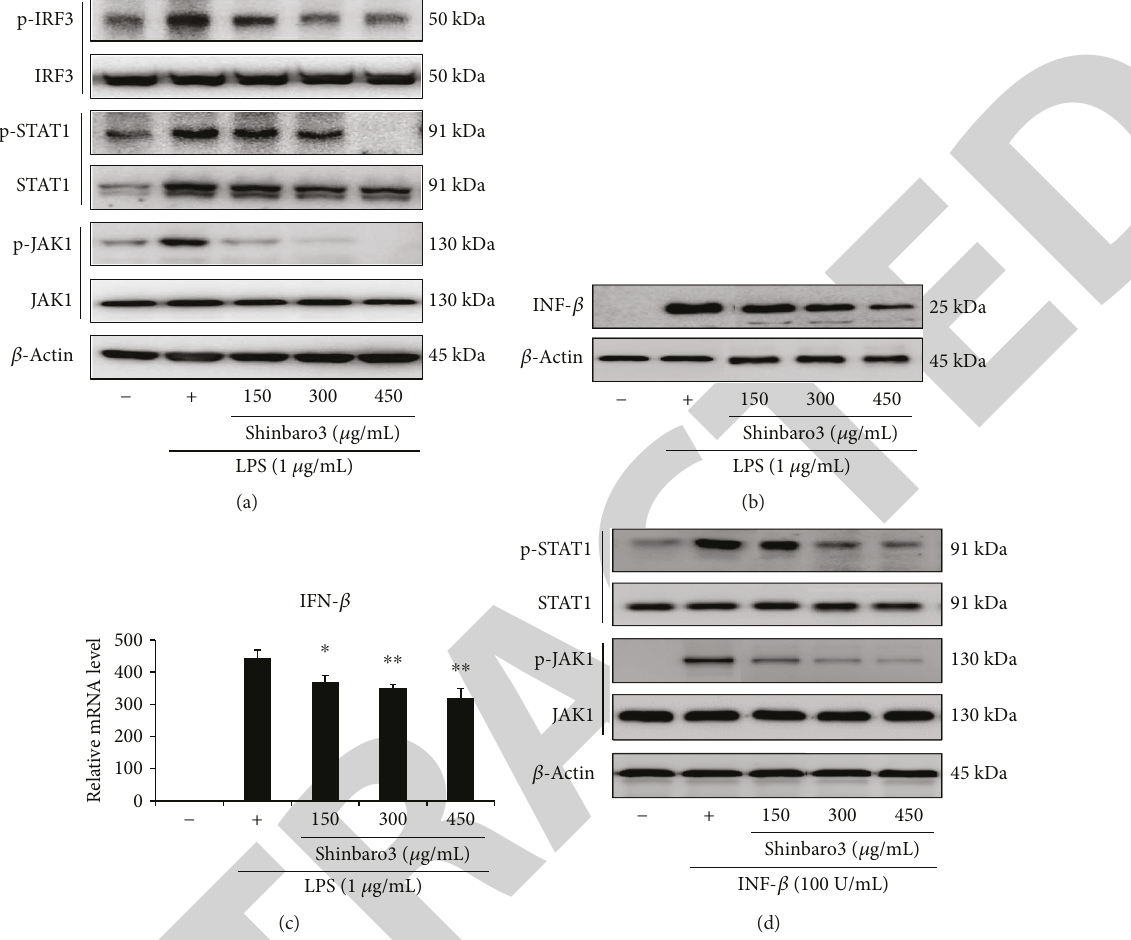
Figure 6: E ff ects of Shinbaro3 on the IRF3/STAT1 signalling pathway in LPS-stimulated RAW 264.7 cells. RAW 264.7 cells were treated with LPS (1 μ g/mL) and Shinbaro3 (150, 300, and 450 μ g/mL) for 4 h. The expression levels of (a) IRF3, STAT1, JAK1, and their phosphorylated forms were detected with speci fi c antibodies. β -Actin was used as an internal control. The data are representative of three separate experiments. (b) Protein expression of INF- β was assessed in RAW 264.7 cells under the above condition. (c) RAW 264.7 cells were treated with LPS (1 μ g/mL) and Shinbaro3 (150, 300, and 450 μ g/mL) for 6 h. Expression of IFN- β was investigated with real-time RT-PCR as described in Materials and Methods. (d) RAW 264.7 cells were stimulated with Shinbaro3 (150, 300, and 450 μ g/mL) in presence of IFN- β (100U/mL) for 4 h. Protein expression of JAK1 and STAT1 and their phosphorylated forms were detected. The data are expressed as the mean ± SD ( n = 3 ). ∗ p < 0 05 , ∗∗ p < 0 01 , and ∗∗∗ p < 0 001 versus LPS treatment